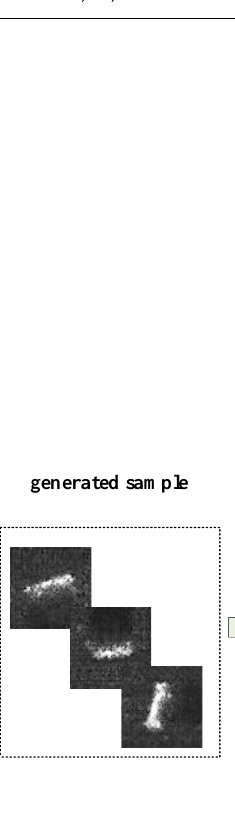
Figure 1. The schematic diagram of counterfactual target samples. Some generated sample looks no different from the real sample. However, it may causes a significant decrease in the performance of the ATR model. The effect of counterfactual target sample on the ATR model may be opposite to the effect perceived by the naked